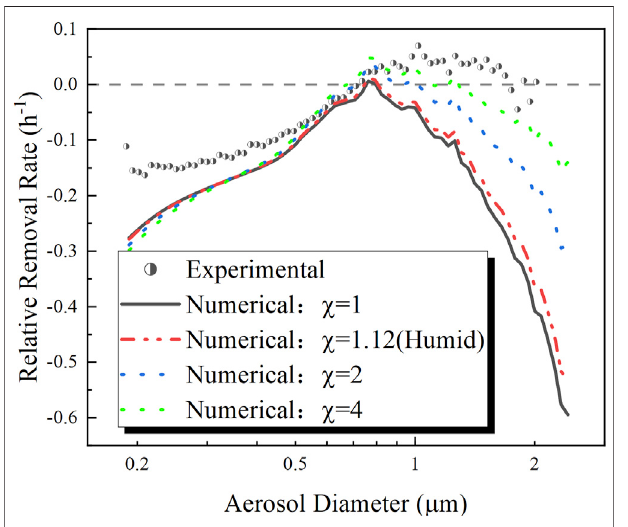
FIGURE 7 | Max discrepancy between the relative removal rate of the experimental result and the numerical result.